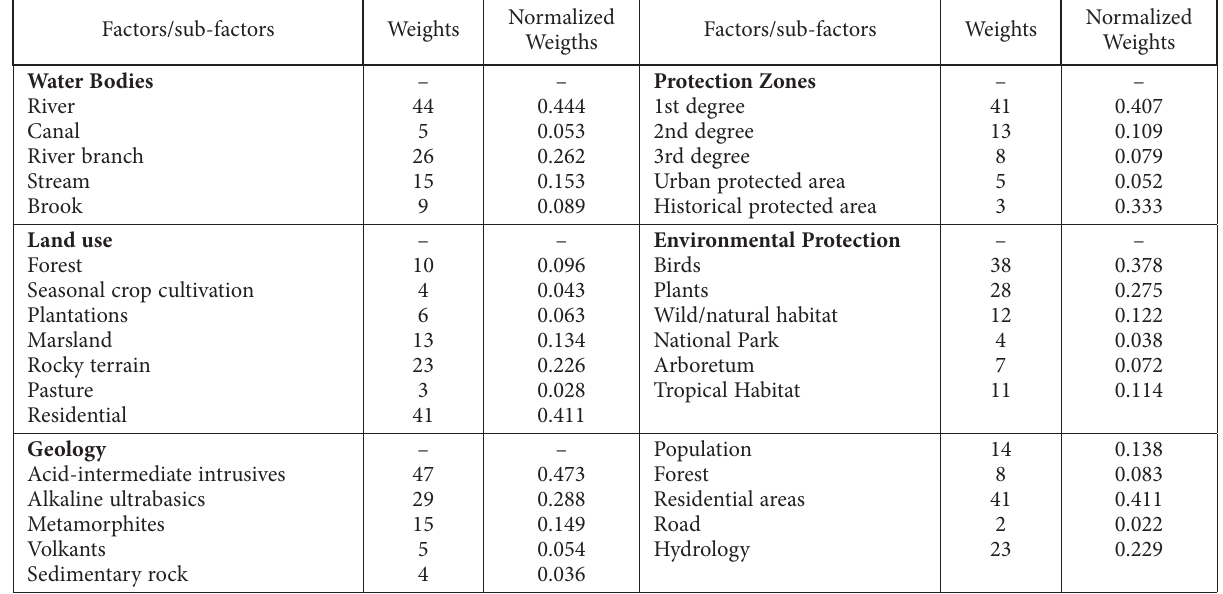
Table 1. Solid waste landfill factor